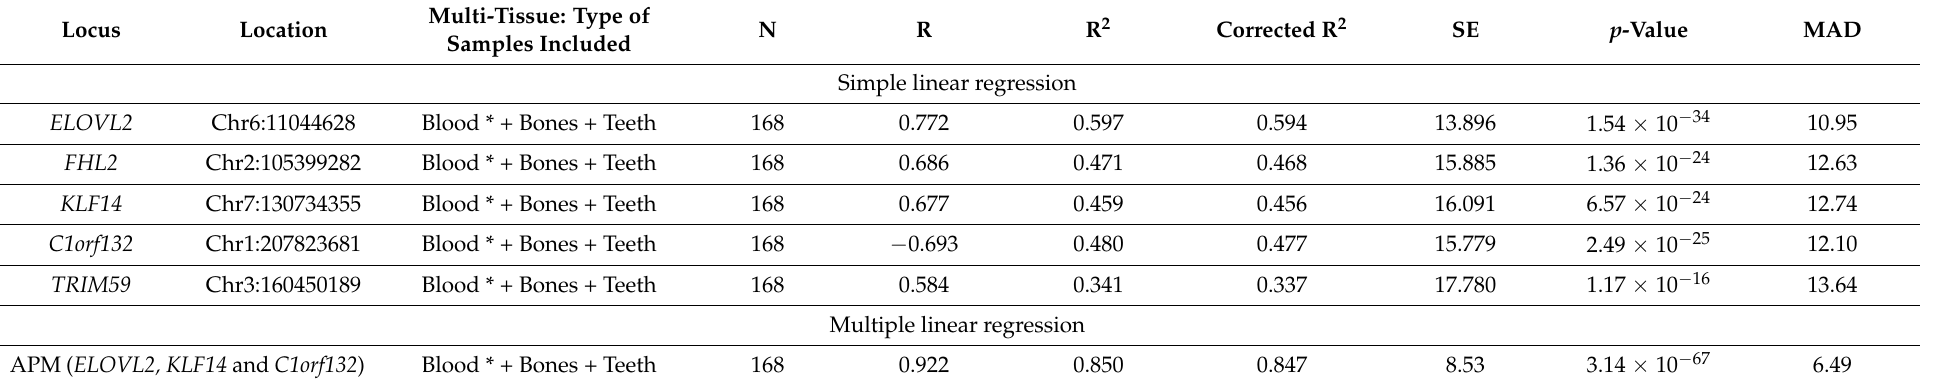
Table 2. Simple and multiple linear regression statistics at the five CpGs of the ELOVL2, FHL2, KLF14, TRIM59 and C1orf132 genes to test for association between the DNAm levels and chronological age using SNaPshot